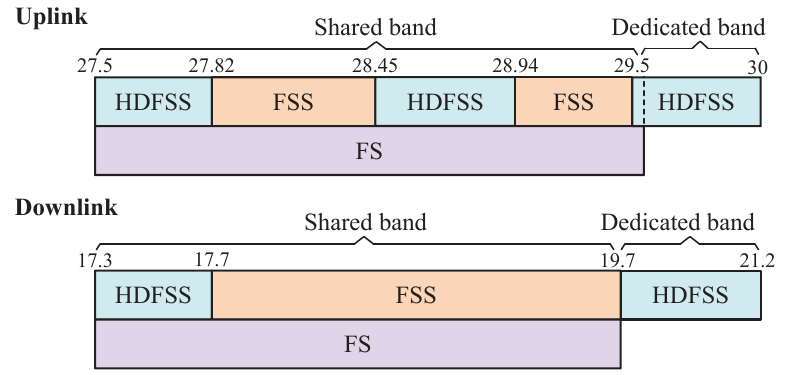
Figure 1. The proposed cognitive HTS system architecture.